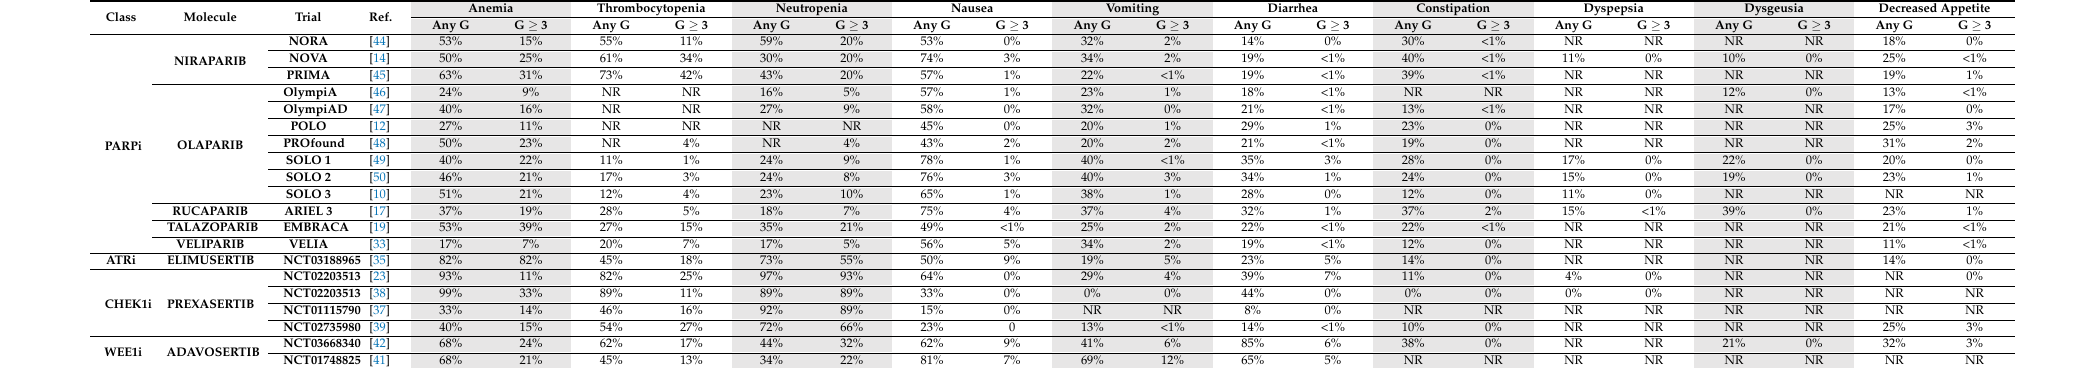
Table Legend: G grade; NR not